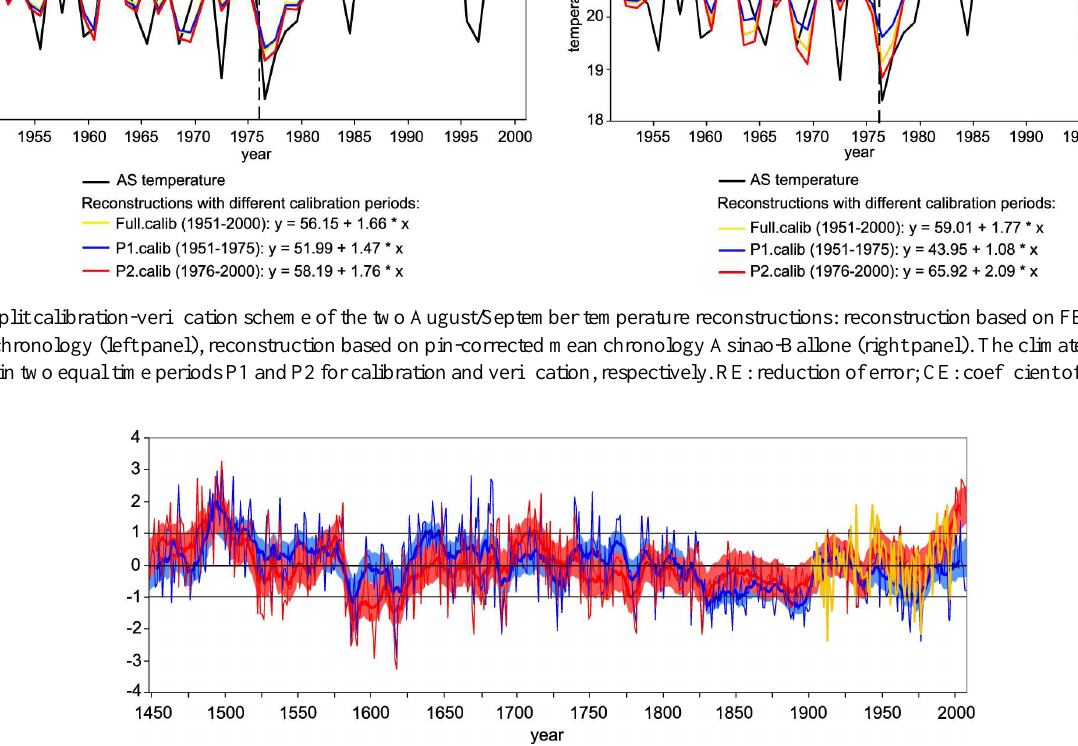
Fig. 4. Reconstructed August/September temperature derived from the FE-corrected carbon isotope chronology of site Asinao (red) and the pin-corrected mean carbon isotope chronology of sites Asinao-Ballone (blue) presented as deviation from the mean 1951–2000AD. The smoothed lines represent an 11-yr running mean, the red and blue shaded areas around the chronologies illustrate the calibration ( ± 1 standard deviation). Orange line shows the instrumental record, horizontal lines indicate the mean and ± 1 standard